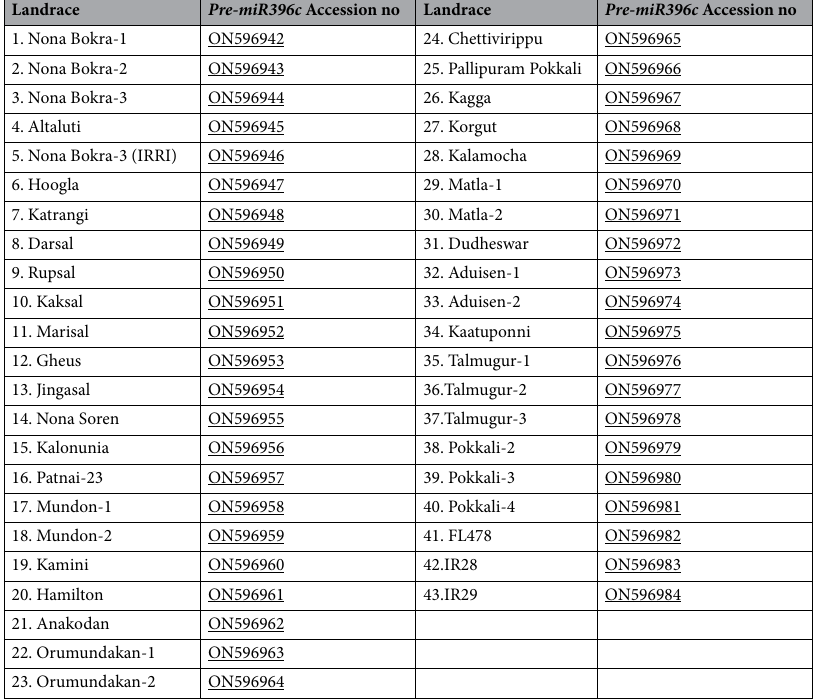
Table 3. List of rice landraces used for SNP validation and accession numbers of precursor miR396c sequences. Landraces used in this study are according to 25 . Underlined text provides a clickable link to the corresponding DNA sequence at the NCBI database https:// www. ncbi. nlm. nih. gov/.